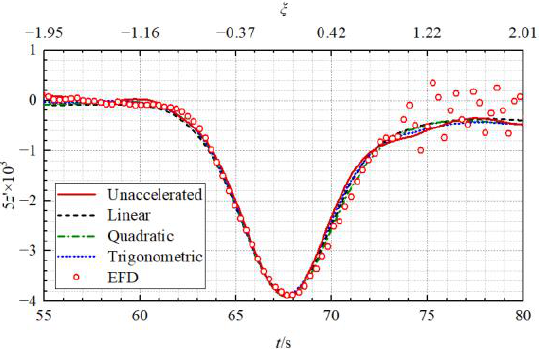
Figure 12. Time histories of free-surface elevations at the wave gauge position under the impacts of the primary wave system.